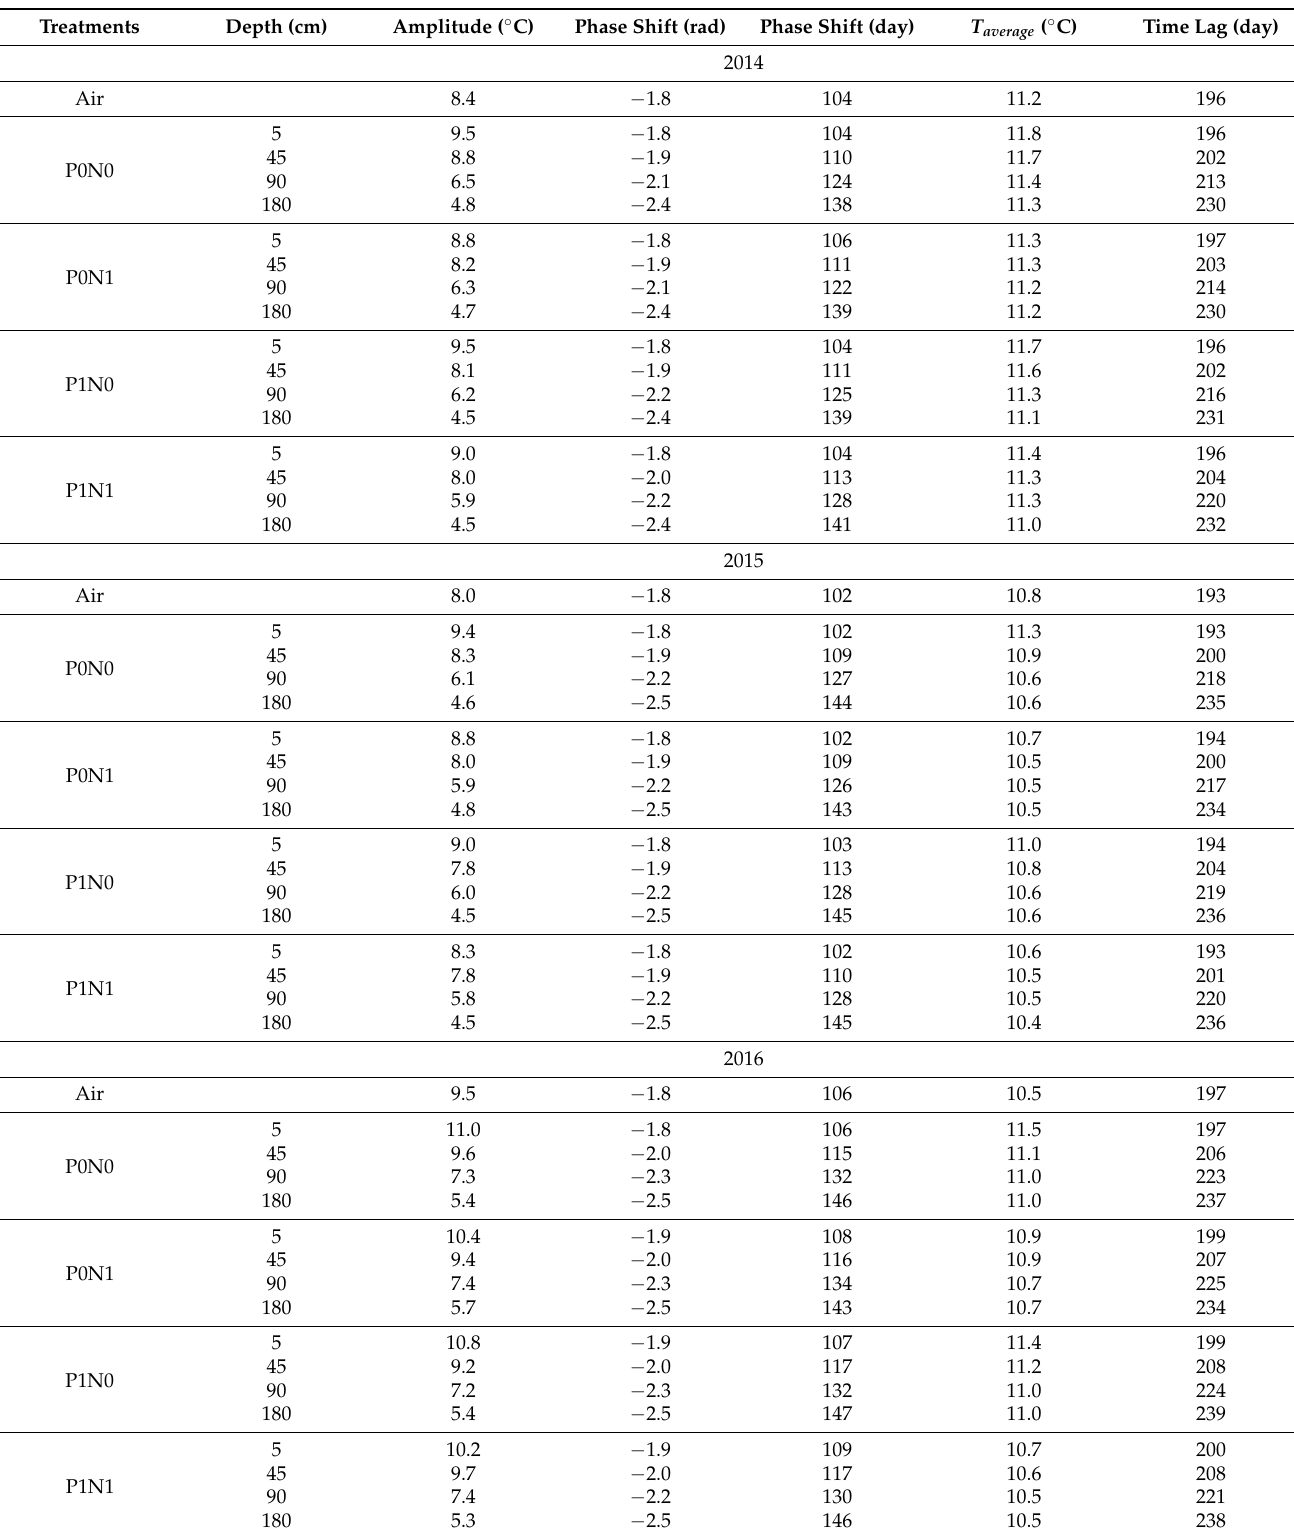
Table 4. Fitted parameters of the sinusoidal wave of soil temperature variation in the different soil layers under different managements during studied